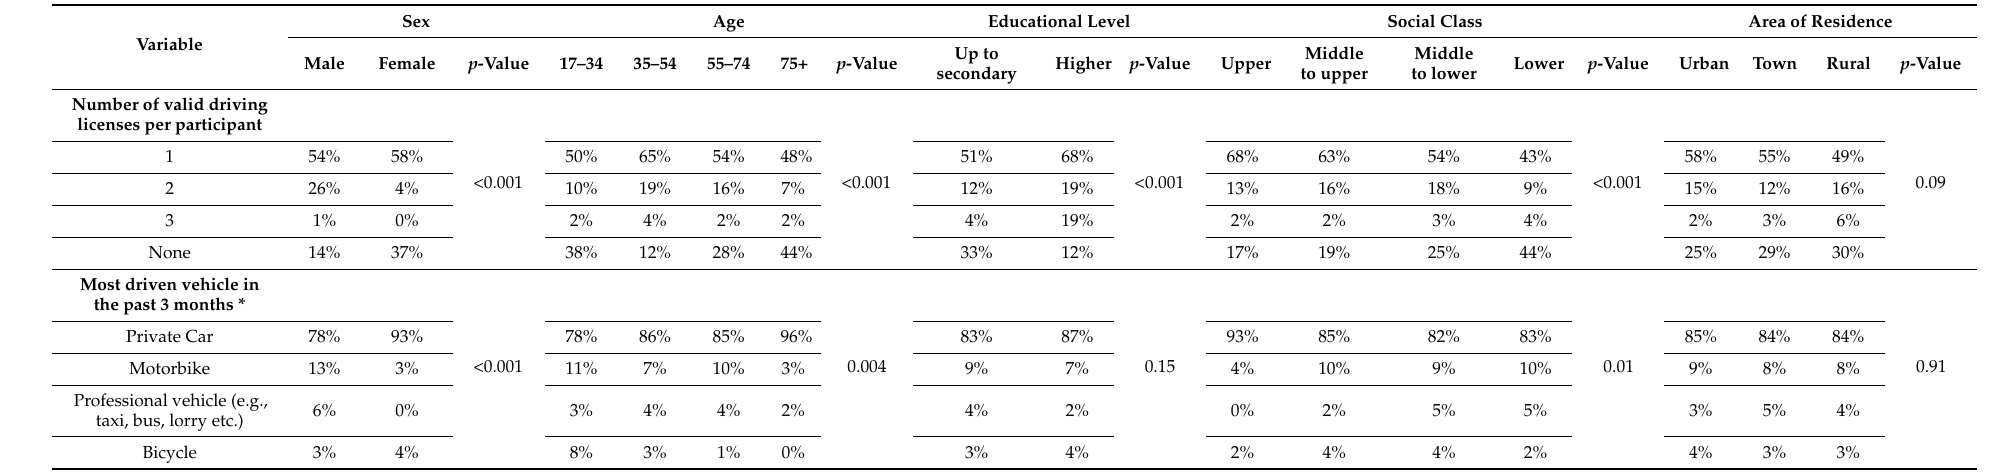
Table 5. Number of valid driving licenses and mostly driven vehicle by demographic characteristics of participants.